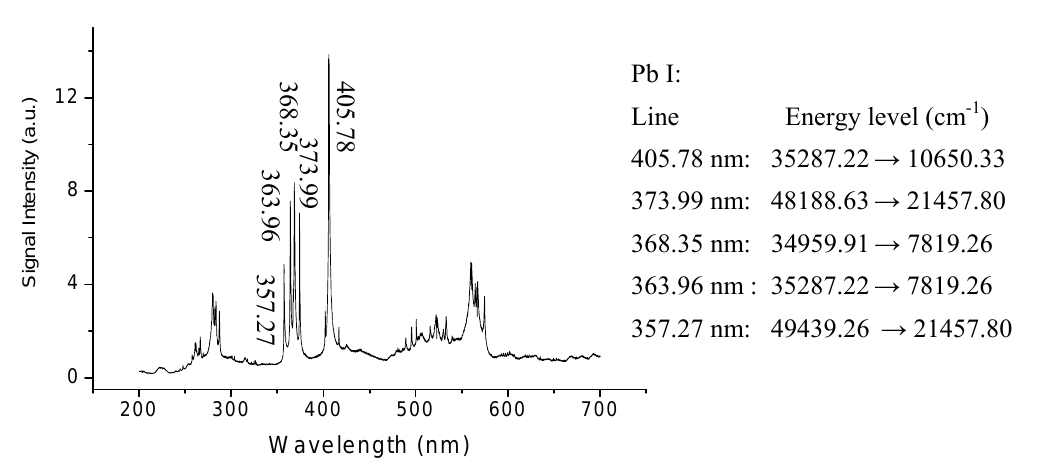
Figure 2. Filament-induced lead spectrum recorded with a Lidar configuration. The sample was located at 2.8 m away from the focal lens, and the gate width of the ICCD detector was 2 μ s and the delay time was − 3 ns with regard to the laser arriving time on the lead target. As an example, several strong lines in the spectrum are assigned to Pb